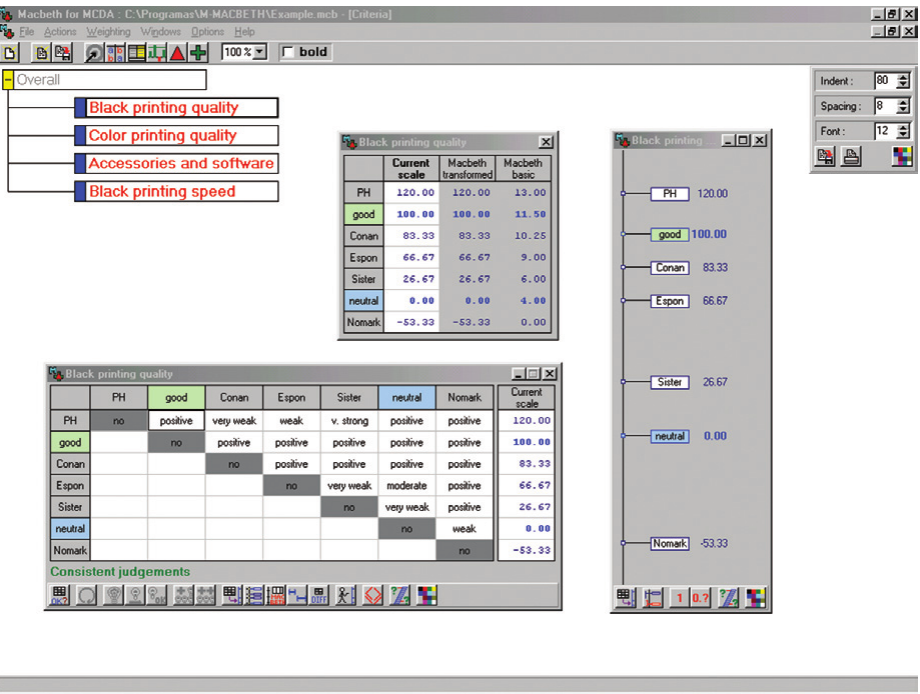
Fig. 3. The MACBETH approach (Matrix of judgments, weights and cardinal value